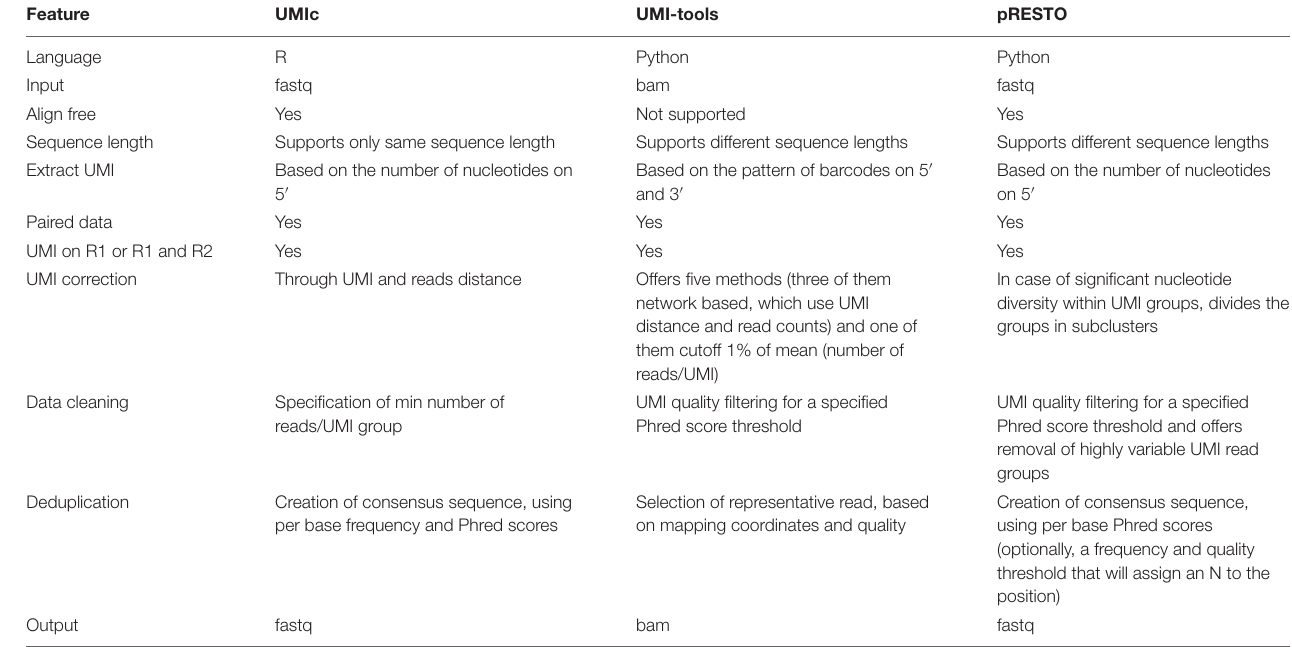
TABLE 3 | Comparison of functionalities offered by UMIc, UMI-tools, and pRESTO.